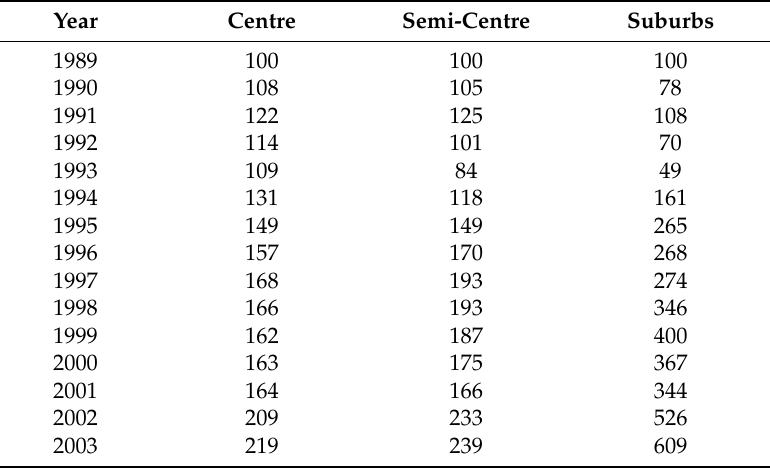
Table 1. An example of data in the Municipality of